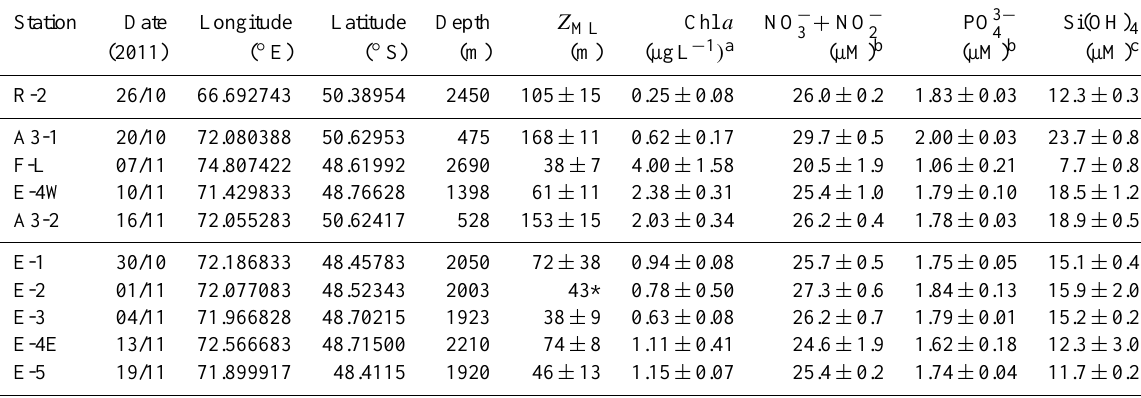
Table 2. Brief description of the main stations. The depth of the mixed layer ( Z ML ) is based on a difference in sigma of 0.02 to the surface value. The mean Z ML ( ± SD) of all CTD casts performed during the occupation of the stations is given. For chlorophyll a and major inorganic nutrients mean values ± SD for the mixed layer are given. A3-1 and A3-2 refer to two consecutive visits of station A3. ∗ : a single cast